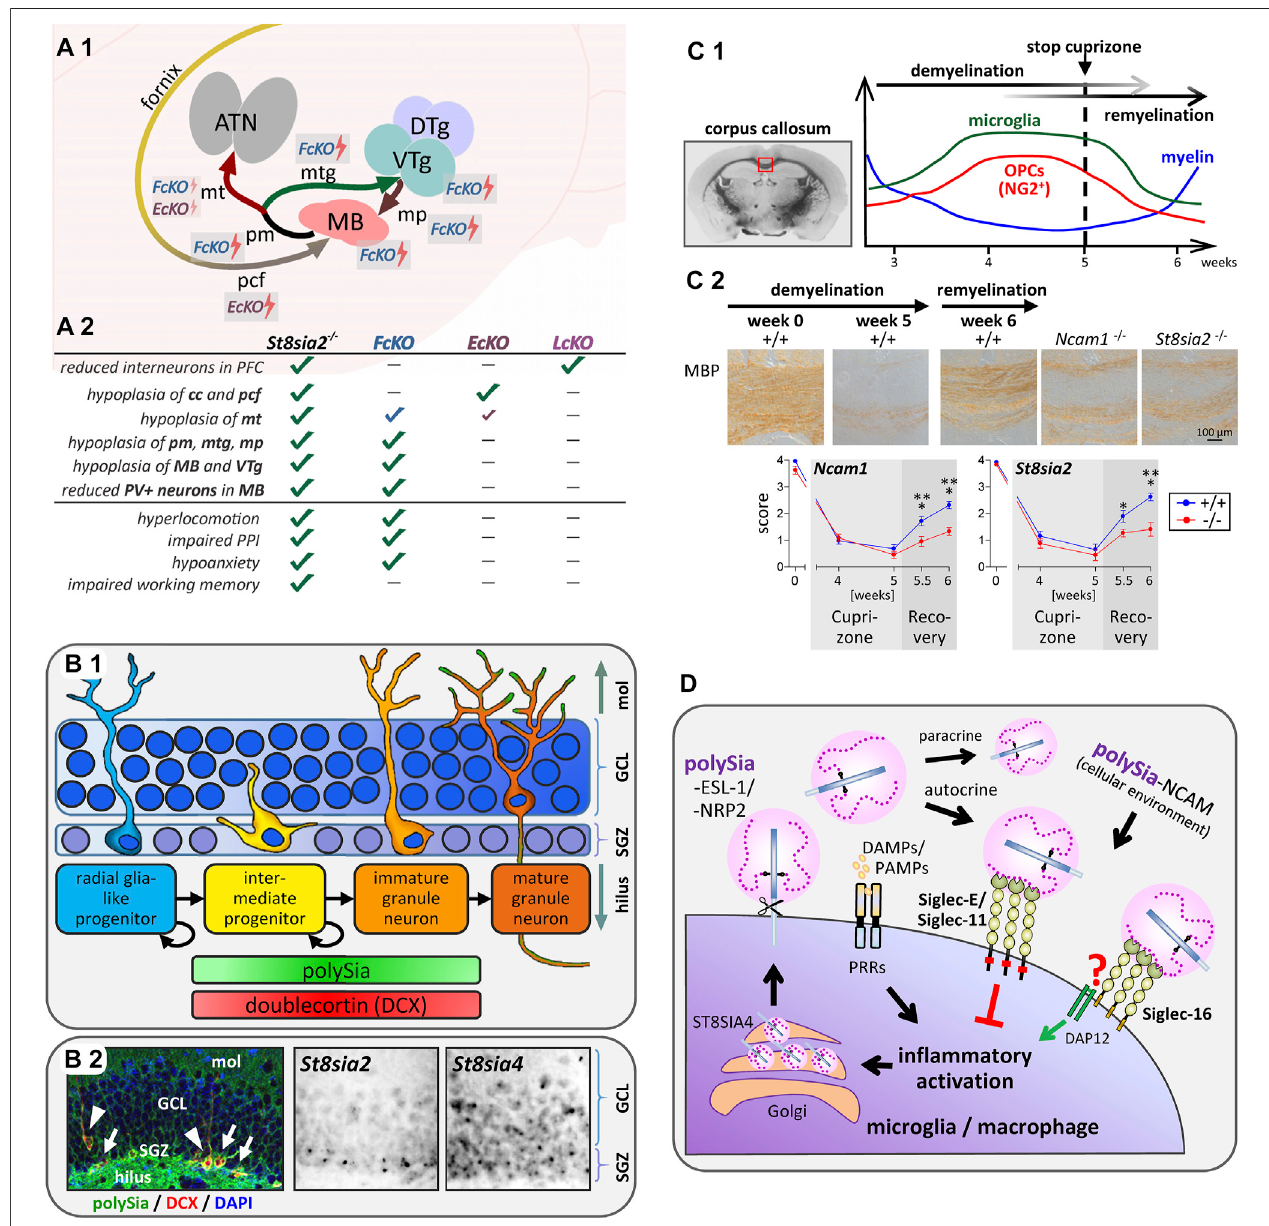
FIGURE 2 | Implications of polysialylation for the neurodevelopmental basis of psychotic behavior, hippocampal neurogenesis, myelin repair and Siglec-mediated immunomodulation. (A) Schematic overview of mammillary body (MB) connectivity affected by conventional or conditional knockout of St8sia2 and its behavioral consequences. (A1) The MB is a group of hypothalamic nuclei, which receives its major input from the subiculum of the hippocampus via the postcommissural fornix (pcf),andsendsprojectionstotheanteriorthalamicnuclei(ATN)viathemammillothalamictract(mt).Themtisformedbycollateralsoftheprincipalmammillarytract (pm),whichcontinuesasmammillotegmentaltract(mtg)towardstheventralanddorsaltegmentalnucleiofGuddeninthemidbrain(VTg,DTg).Reversely,themammillary peduncle (mp) projects from these tegmental nuclei to the MB. St8sia2 − / − mice show hypoplasia of MB and VTg, and of all afferent and efferent MB connections. As indicatedbythelightningsymbols,both Emx1-Cre;St8sia2 f/f ( EcKO )and Foxb1-Cre;St8sia2 f/f ( FcKO )showmthypoplasia,butlesspronouncedthanin St8sia2 − / − mice, whereas EcKO and St8sia2 − / − mice show the same hypoplasia of the pcf, and FcKO fully reproduce all other de fi cits of MB, VTg and their reciprocal connections. (A2) Summaryoftheneurodevelopmentalmorphologicalde fi citsandbehavioraltraitsin St8sia2 − / − micethatarefully( ✓ ),largely( ✓ ),partially( ✓ ),ornot(-)reproducedin FcKO , EcKO or Lhx6-Cre;St8sia2 f/f ( LcKO )mice.cc,corpuscallosum.Assessedbehavioraltraitsare(i)increasedsensitivityofthelocomotorresponsetothepsychotropicdrug MK-801(hyperlocomotion),(ii)exacerbatedapomorphine-inducedimpairmentofprepulseinhibitionoftheacousticstartleresponse(impairedPPI),(iii)reducedanxietyin the elevated plus maze (hypoanxiety), and (iv) impaired spatial working memory in a delayed nonmatch-to-place T-maze task. Data compiled from Küçükerden et al. (2022). (B) Scheme of neurogenesis, occurrence of polySia and doublecortin, and expression of polySTs in the dentate gyrus of the hippocampal formation. (B1) In the subgranular zone of the dentate gyrus (SGZ), slowly dividing astrocytic, GFAP-positive radial glia-like progenitors give rise to dividing intermediate progenitors, which migrate into the granule cell layer (GCL) while differentiating towards unipolar immature and fi nally mature granule neurons with polySia-negative somata, but polySia on ( Continued )